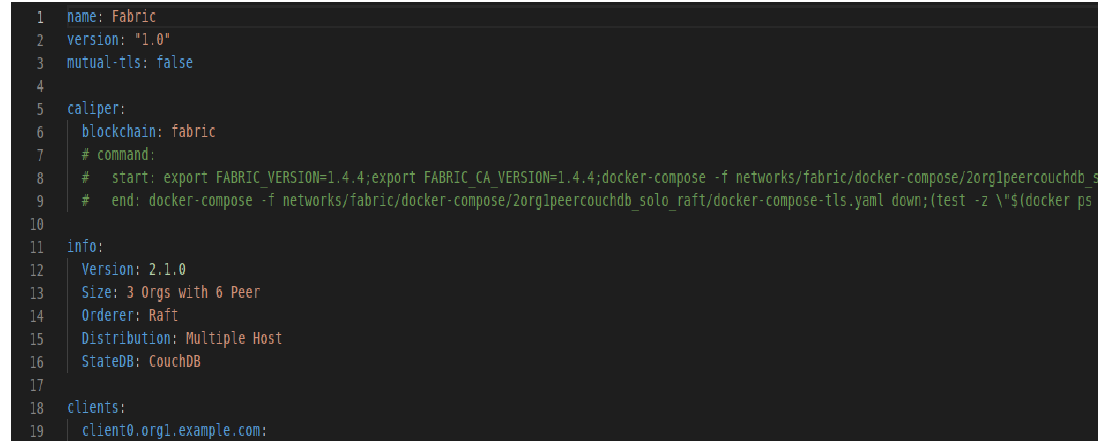
Figure 15. Docker file used for setting up the Hyperledger Caliper.